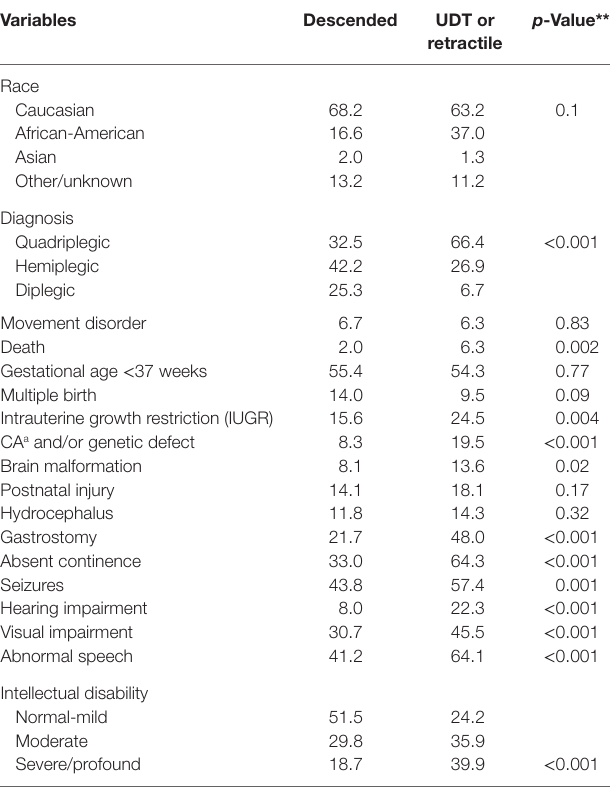
TaBle 3 | Univariable logistic regression analysis comparing the prevalence of clinical characteristics/comorbidities based on cryptorchidism subtype. UDT or retractile UDT Or